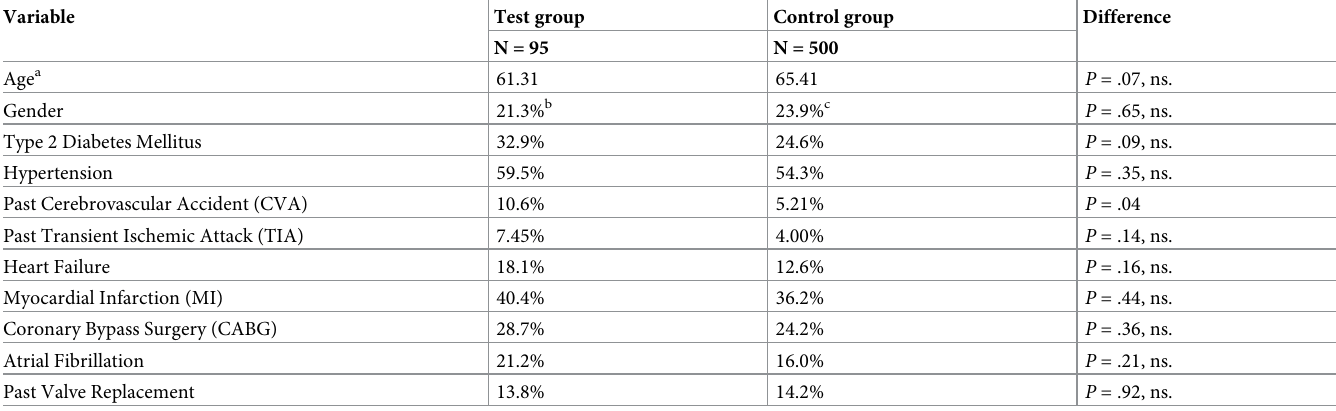
Table 1. Patient demographics and prior diagnoses.